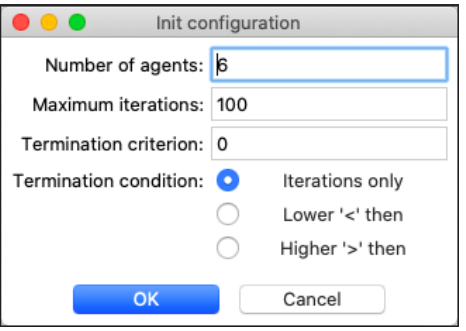
Figure 3. Defining GWO inputs in the application.